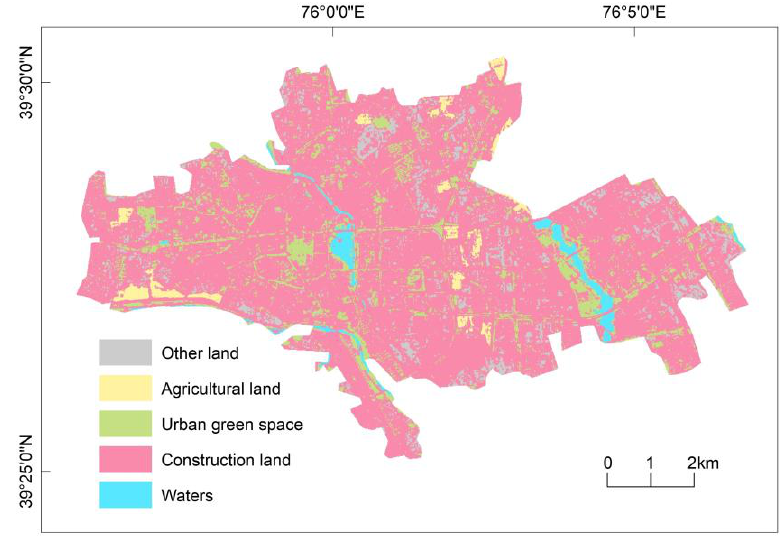
Figure 3. Spatial distribution of urban land use in Kashgar city.